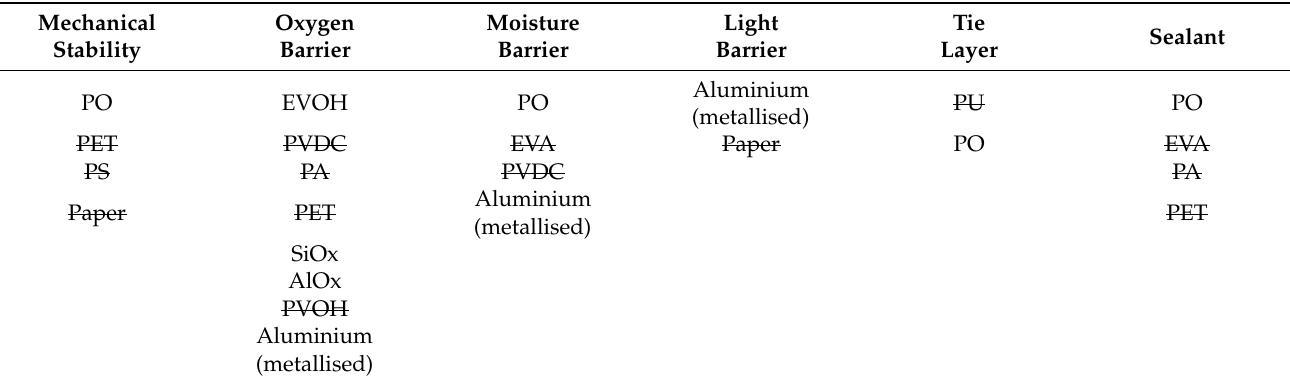
Table 4. Materials suggested for recyclable multilayer flexible food packaging. Modified after the works in [10,11,13,27–